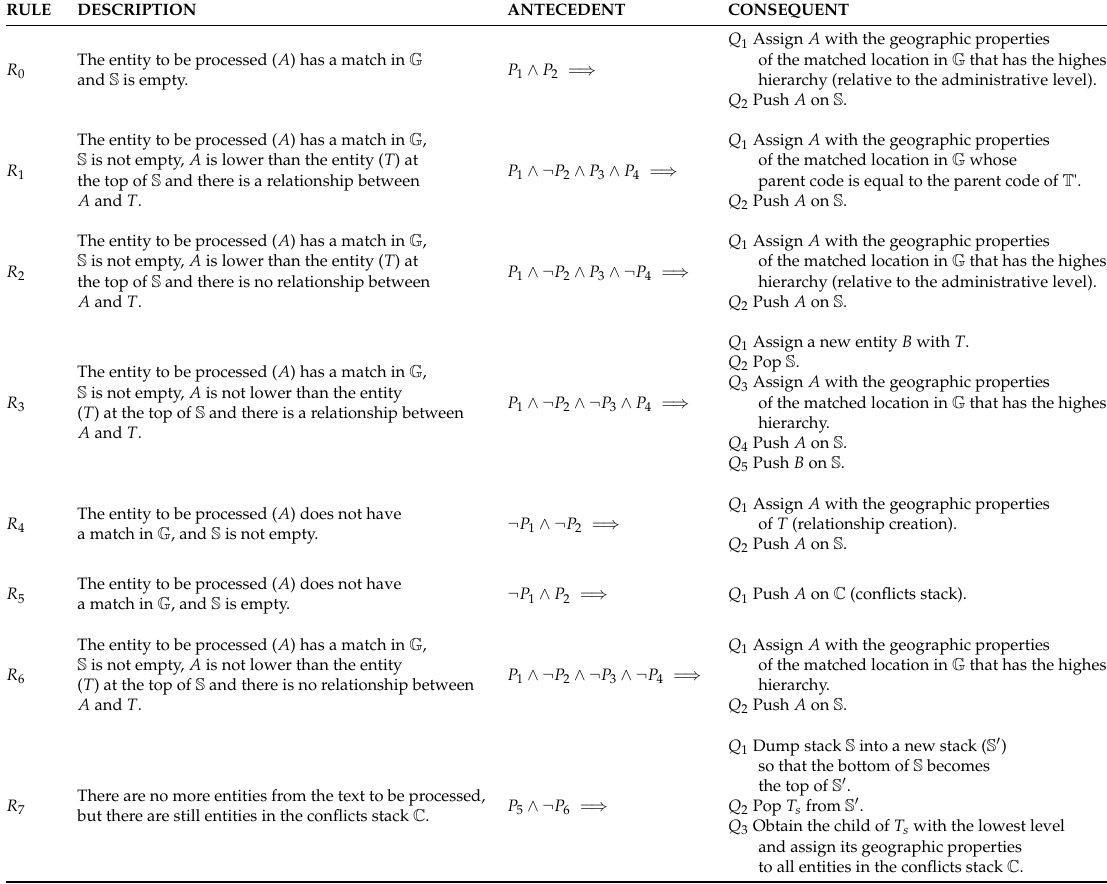
Table 1. Set of rules for dynamic context